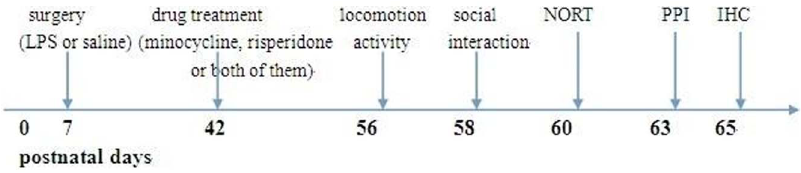
Figure 1. The timeline of treatment, behavioral testing and IHC.